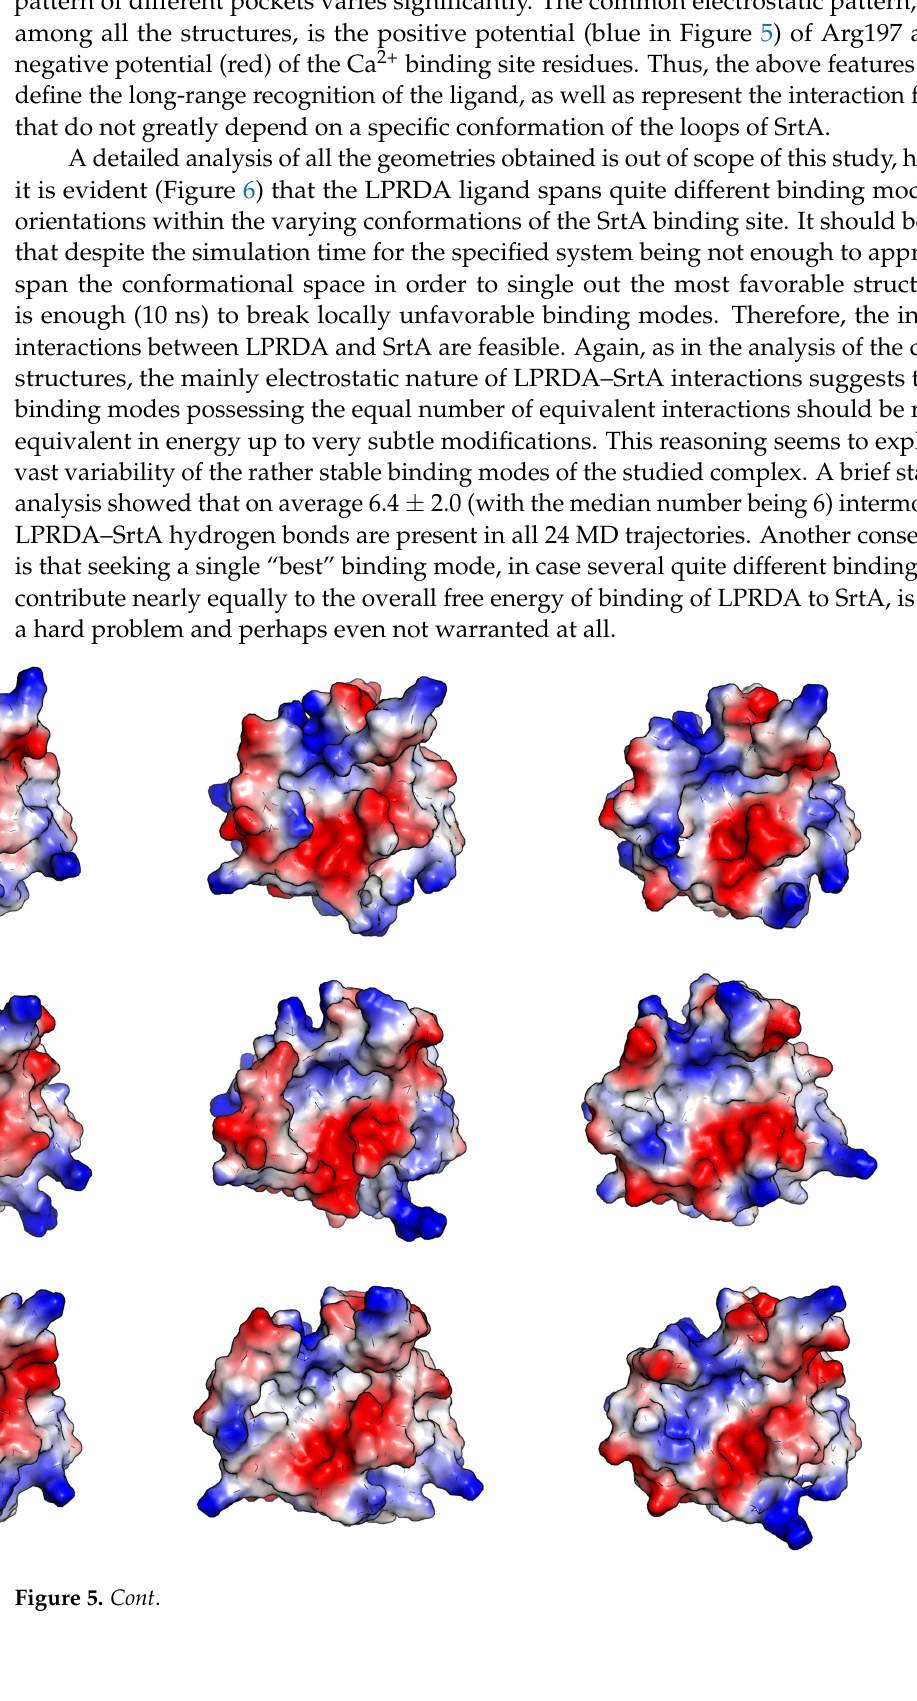
Figure 4. ( A ) Cartoon representation of the geometries of SrtA for each of the eight complexes and three replicas, overlayed onto the PDB:1T2W structure (shown outlined) using the function cealign of PyMol. ( B ) The simple electrostatic potential surface, generated for the PDB:1T2W structure in the same view as in the left